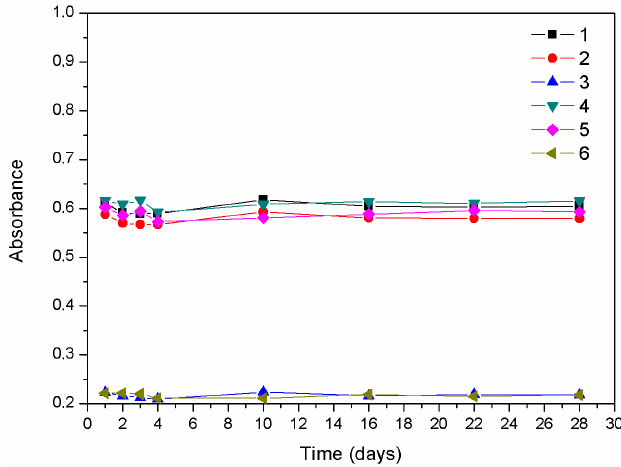
FIGURE 4 - Stability of 10 mg L -1 folic acid solutions in the absence of light, using 0.1 mol L -1 Na 283.0 nm (2), 365.5 nm (3)) and 0.1 mol L -1 NaOH (255.5 nm (4), 283.0 nm (5), 365.5 nm (6)).